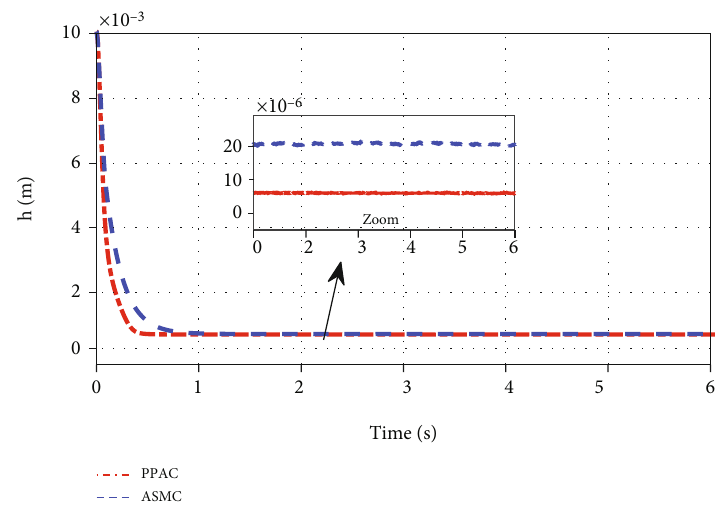
Figure 8: h responses of the closed-loop system with Case 1.